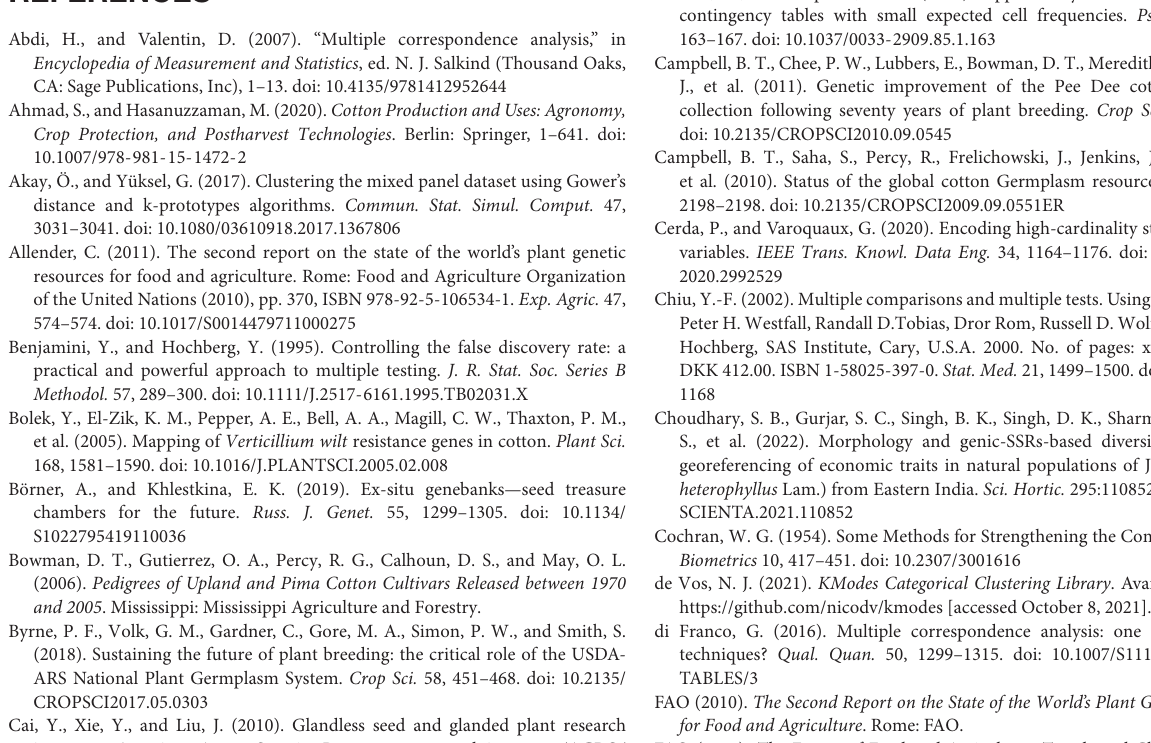
Supplementary Figure 3 | Heatmap of the bivariate descriptor associations for Gb. Supplementary Figure 4 | Leaf hair – stem hair analysis. Supplementary Figure 5 | Lint color – seed fuzz color analysis. Supplementary Figure 6 | Boll glanding – leaf glanding – stem glands analysis. Supplementary Figure 7 | Heatmaps of SA-251, TEX-308, and TEX-156 sets. Supplementary Figure 8 | Multiple correspondence analysis for SA, TEX, and Gb. Supplementary Figure 9 | Cloud of descriptor correlations.